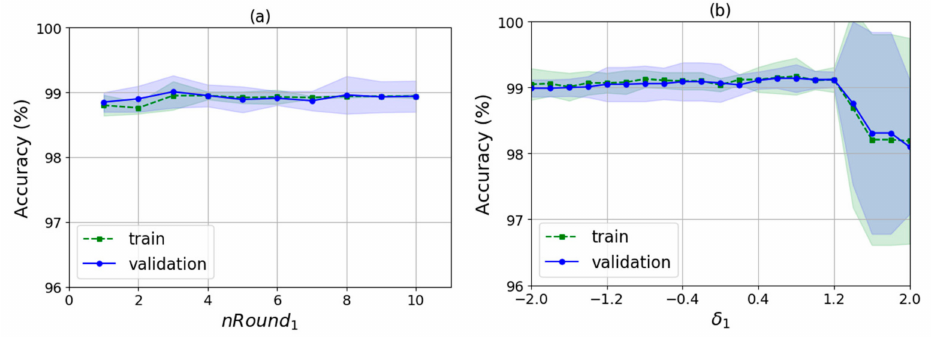
Figure 4. Accuracy of fine-grained classification of encrypted network flows based on improved KNN (FCE-KNN) for identifying encryption status of network flows with di ff erent values of k 1 : ( a ) k 1 from 1 to 101, interval 10; ( b ) k 1 from 1 to 20, interval 1.